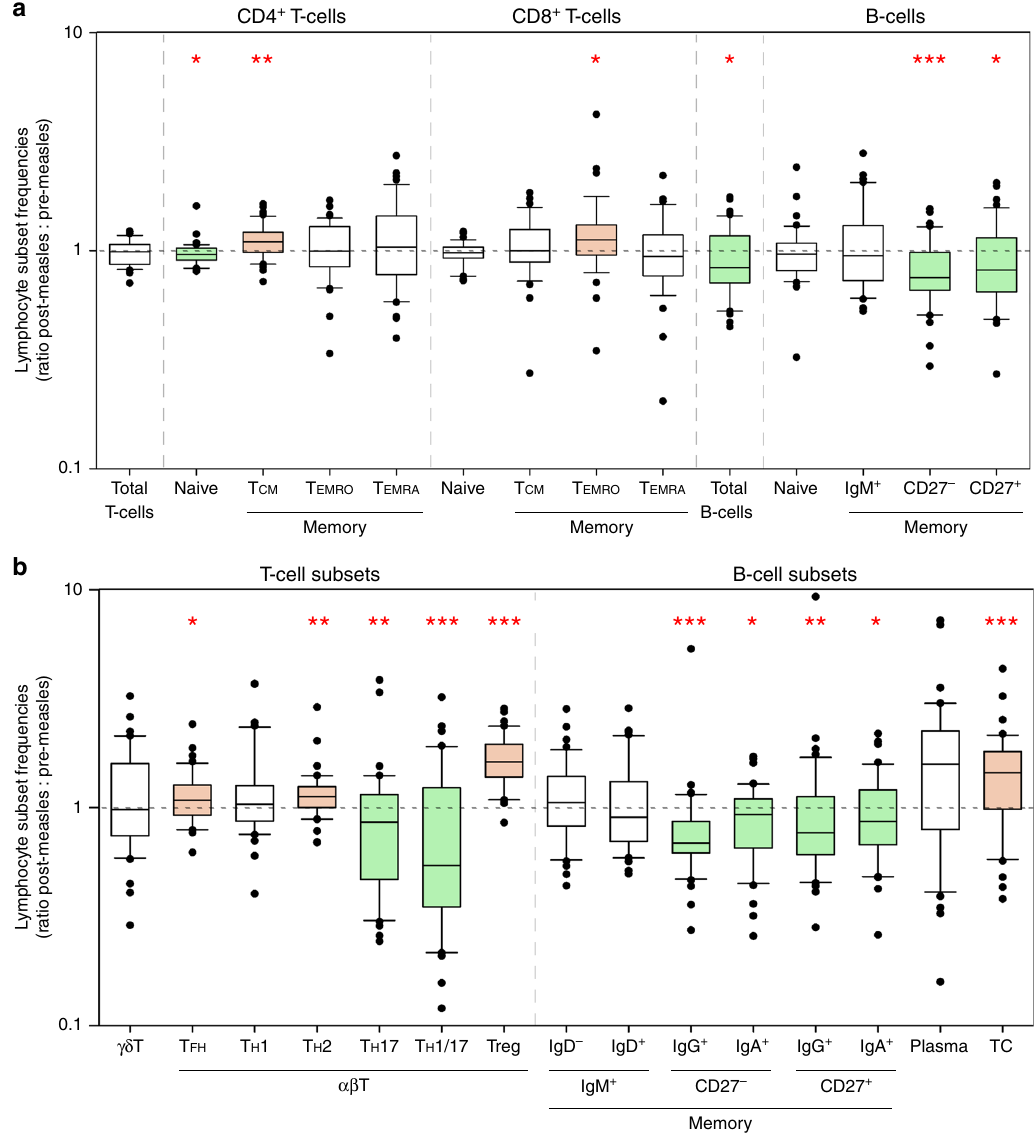
Fig. 5 Signi fi cant changes in the frequencies of different lymphocyte subsets after measles. Frequency ratios of a naive or memory lymphocyte subsets or b functionally distinct T and B cell subsets ( n = 42 paired samples). The ratio was calculated as the frequency of a subset after measles divided by the frequency of the same subset before measles. Horizontal dashed line indicates no changes ( ‘ ratio = 1 ’ ) in frequency after measles. Ratio ‘ >1 ’ indicates increase and ratio ‘ <1 ’ indicates decrease in lymphocyte subset frequency after measles. Vertical dashed lines separate different lymphocyte subsets. T H 1/ 17: T H 1T H 17 cells. CD27 + IgM + IgD − B cells are also known as IgM-only memory B cells. CD27 + IgM + IgD + B cells are also known as natural effector cells. TC: transitional B cells. Green box represents signi fi cant decrease. Orange box represents signi fi cant increase. Statistical differences in frequencies of lymphocyte subsets before and after measles were analysed by two-tailed paired t -test or Wilcoxon signed-rank test. Centre lines of the box plots represent medians. Lower and upper boundaries of the boxes represent fi rst and third quartiles, respectively. Lower and upper whiskers represent the 10th and 90th percentiles of the data, respectively. Dots represent outliers. * P < 0.05; ** P < 0.01; *** P ≤